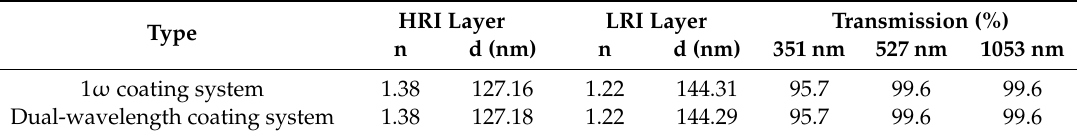
Table 1. Optimized coating design for 1 ω coating system and dual-wavelength coating system from TFCalc ®